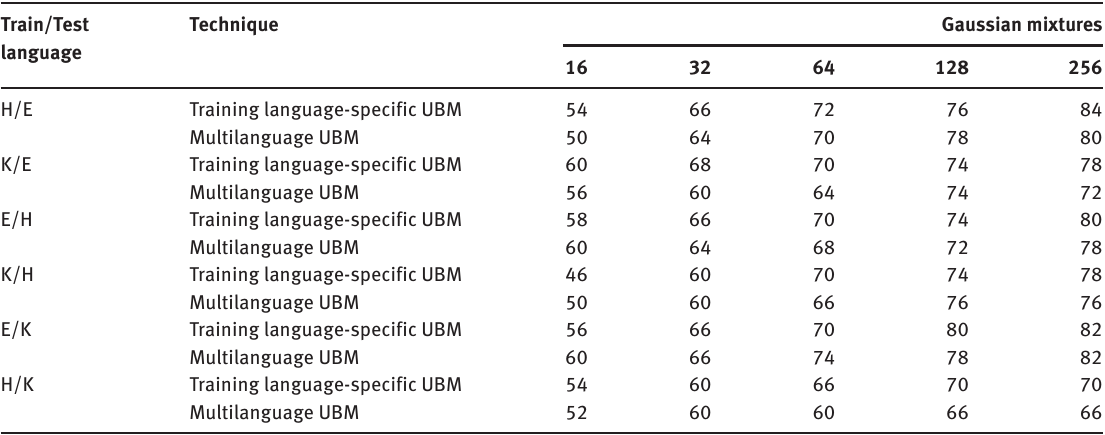
Table 5: Crosslingual Speaker Identification Performance (%) for the 50 Speakers of Our Own Database Using 20-s Training and Testing Data for the GMM-UBM Modeling